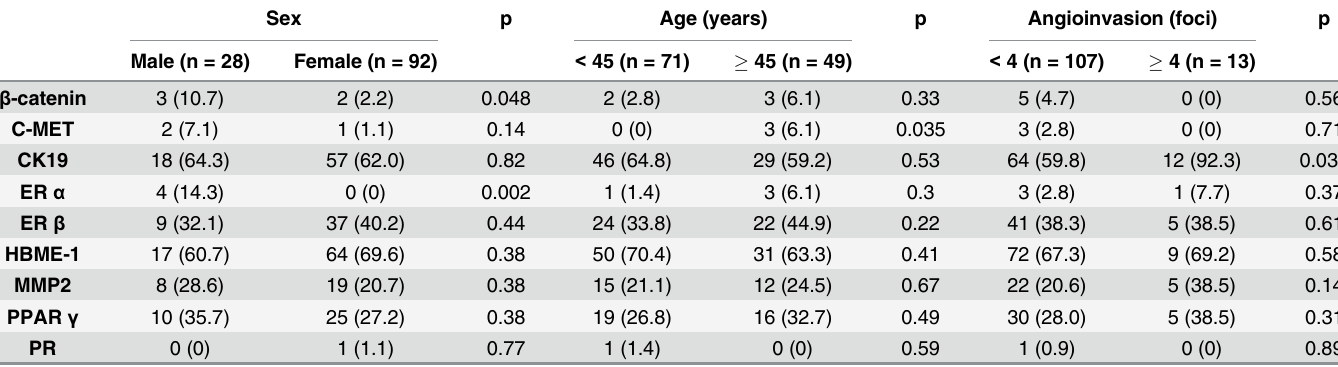
Table 5. Comparison of the expression of protein markers at TMA analysis according to clinicopathologic characteristics. Sex p Age